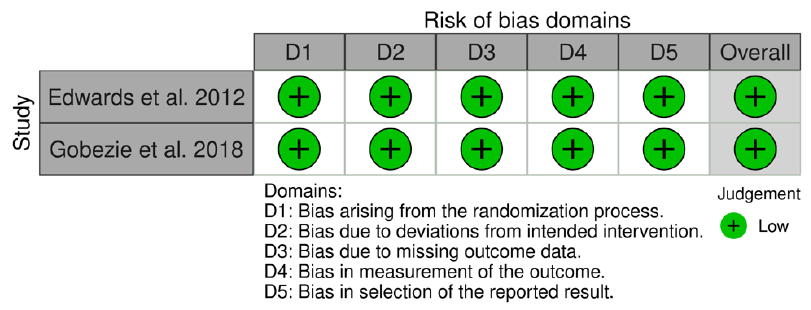
Figure 2. The risk of bias assessments for RCT study [37,38].